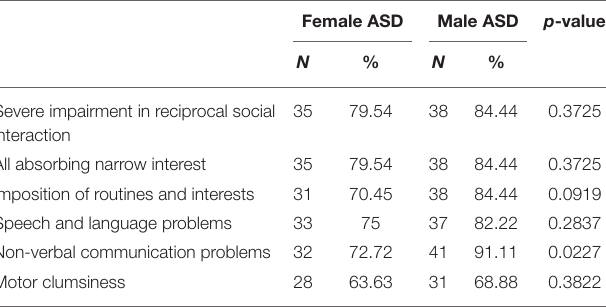
TABLE 6 | Core clinical features obtained from ASDI scores.